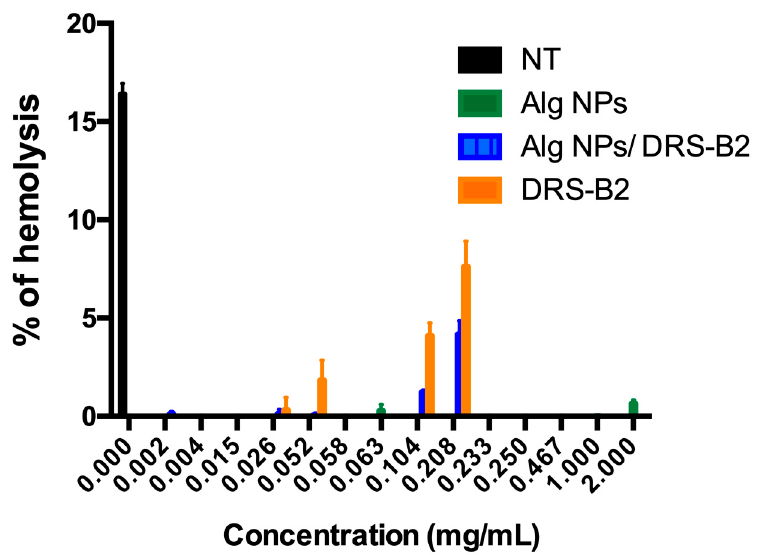
Figure 1. Hemolytic activity of Alg NPs, DRS-B2 alone, and Alg NPs + DRS-B2 on human erythrocytes. Human erythrocytes were cultured without treatment (NT) or upon treatments with different concentrations of Alg NPs, DRS-B2, or Alg NPs (0.500 mg/mL) + DRS-B2 (0.002–0.208 mg/mL) for 1 h at 37 °C.